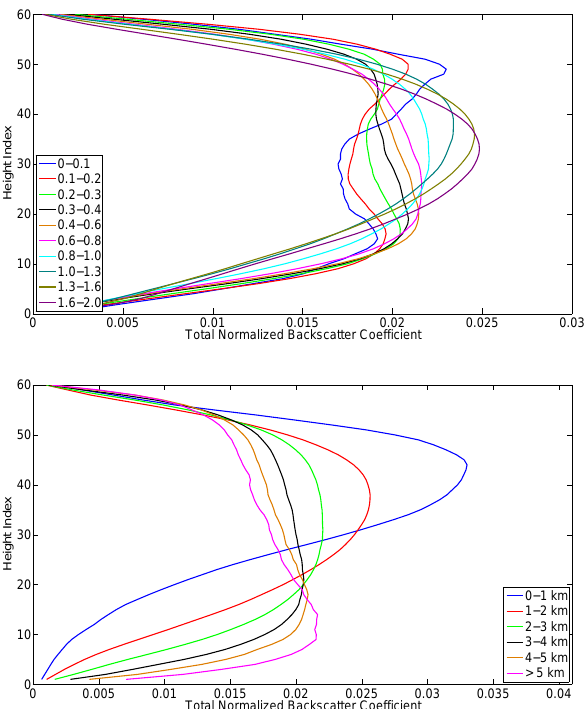
Fig. 8. Upper panel: annual mean BSPs of cirrus clouds for varying optical depth and geometrical thickness between 2.1 and 2.5km. Lower panel: annual mean BSPs for cirrus clouds with nearly the same optical depth (0.8–1.0) and multiple geometrical thicknesses. For both panels ML at nighttime are considered. Fig. 10. AIRS brightness temperature differences for pairs of clouds with same OD but IWC profile that in one case is derived from climatological BSPs and in the other case is assumed constant along the cloud vertical. Four different geometrical thicknesses are considered in the example. Typical ODs are 55 associated to each thickness.